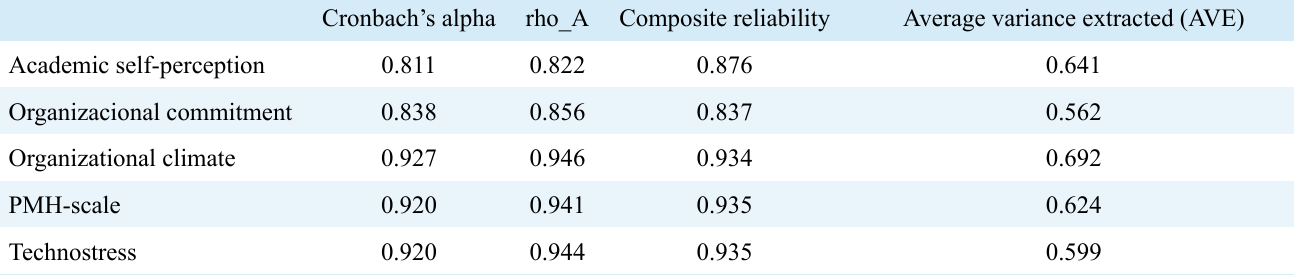
TABLE 2. Cronbach’s Alpha and Composite Reliability.